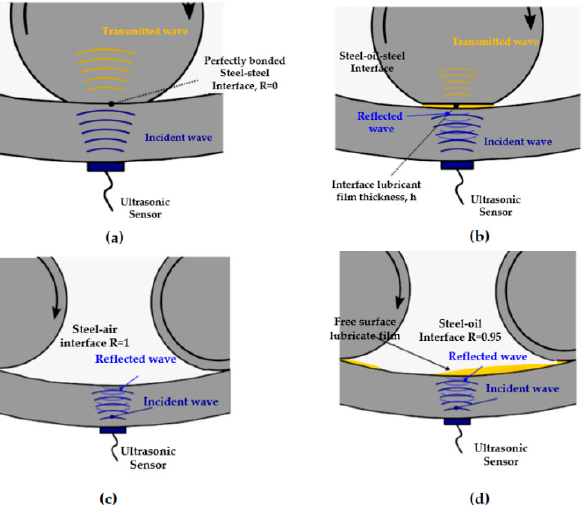
Figure 23. Conceptual diagram of ultrasonic reflectometry [190]. ( a ) Steel–steel interface; ( b ) steel–oil–steel interface; ( c ) steel–air interface; ( d ) steel–oil interface. oil–steel interface; ( c ) steel–air interface; ( d ) steel–oil